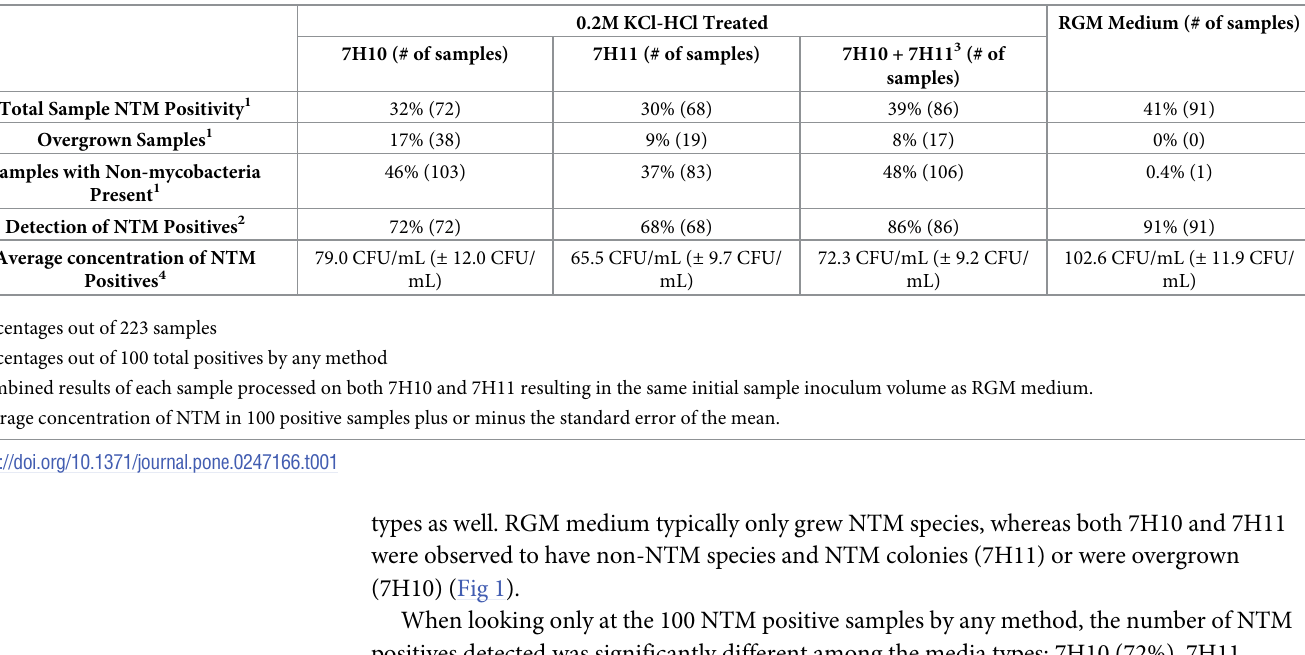
Table 1. Summary of positivity, overgrowth, and non-NTM Isolated on 7H10, 7H11, and RGM medium.